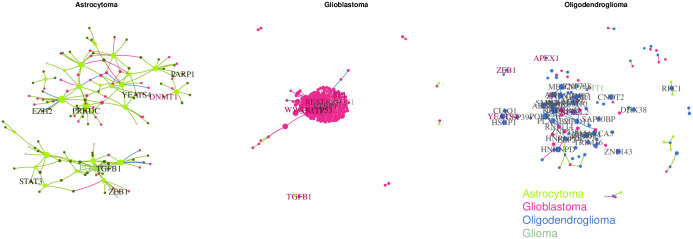
TF-TF CoDiNA networks for each of the Glioma types: CoDiNA identified TFs with specific co-regulatory changes to each cancer, Panel I astrocytoma, Panel II Glioblastoma, Panel III oligodendroglioma.Nodes are coloured according to the type of cancer CoDiNA associated them to. Panel I: We can see that mostly glioma and astrocytoma TFs are specific to the astrocytoma network. Panel II: The majority of nodes refer to specific changes in co-expression in glioblastoma, but there is an overlap with TFs involved in other gliomas. Panel III: Most links and genes are specific to oligodendroglioma, with some overlap of astrocytoma TFs.